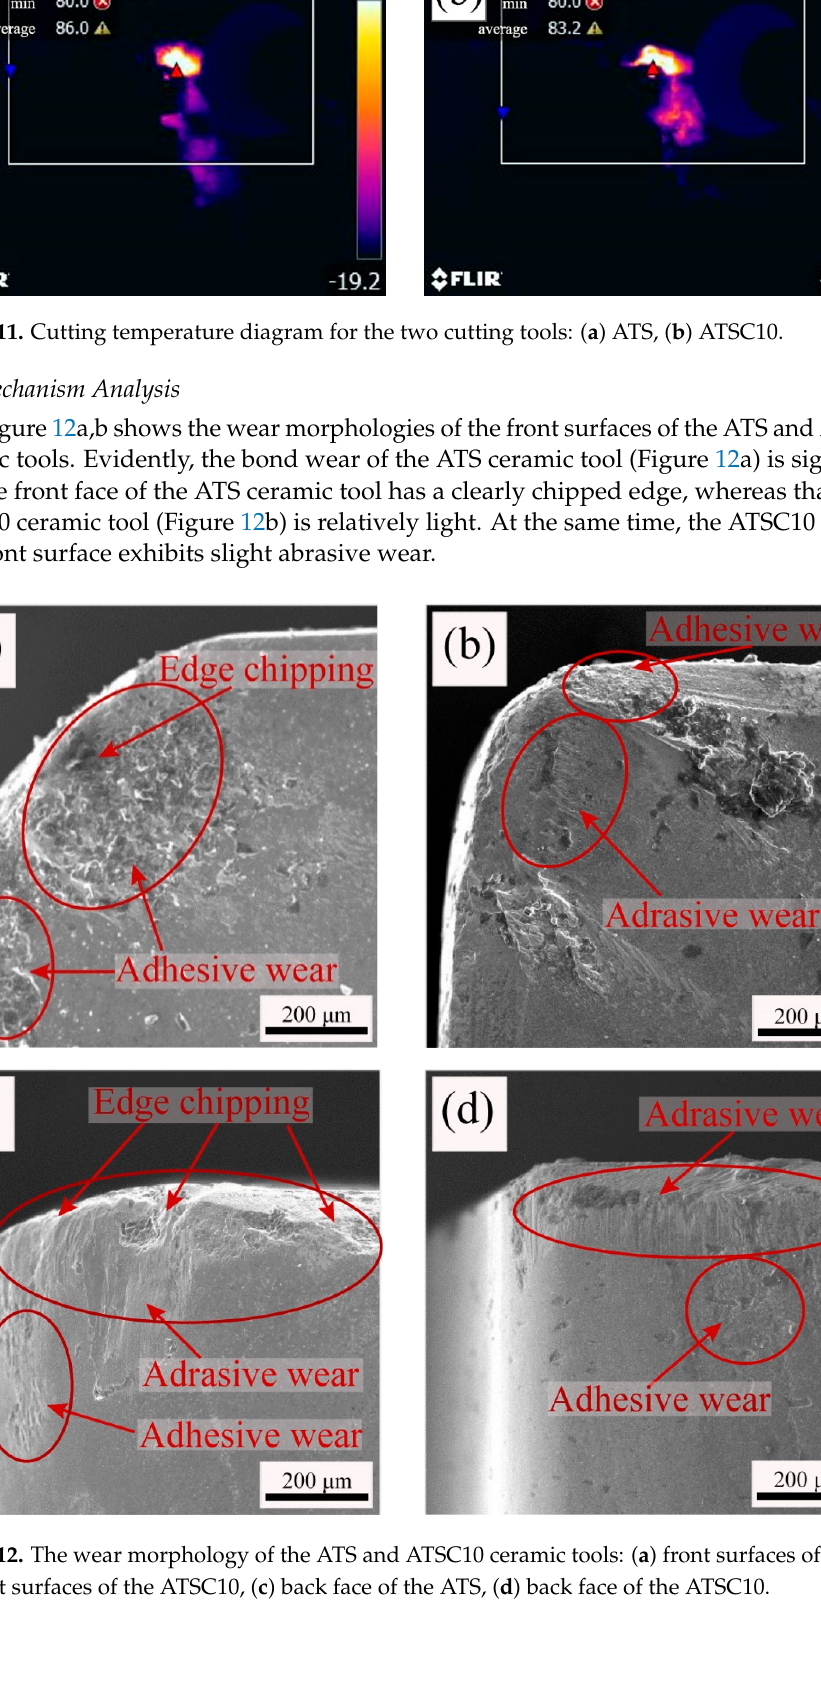
16 of 22 Figure 10. Comparison of cutting forces of the two types of tools. Effect on Cutting Temperature Figure 11 shows a comparison of the cutting temperatures of the ATS and ATSC10 ceramic tools at a cutting speed of 300 m/min after reaching a stable cutting stage. The other cutting parameters are as follows: cutting depth ap = 0.2 mm and feed rate f = 0.102 mm/r. As shown in Figure 11, the cutting temperature of the ATS ceramic tool under this